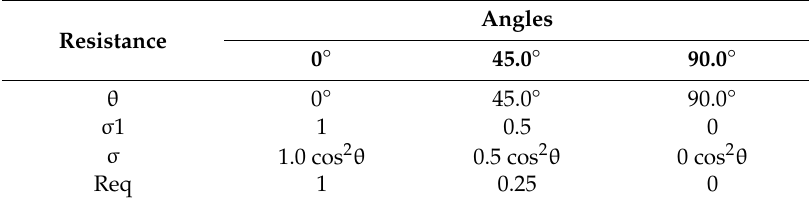
Table 2. Predicted simple resistor model of one-ply conductivity.